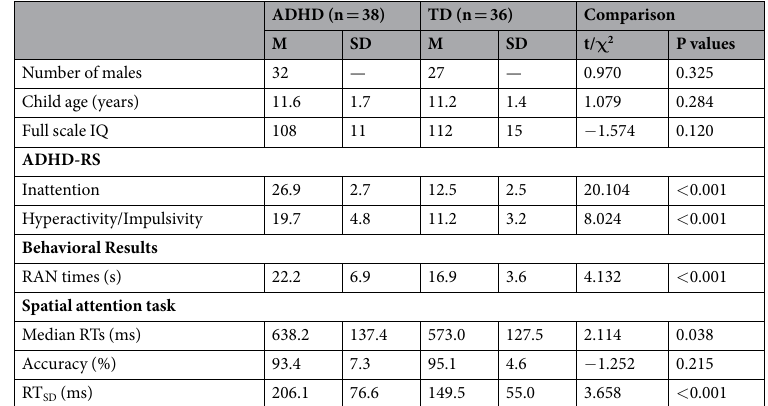
Table 1. Sample characteristics and behavioral results in the ADHD and TD groups. ADHD: attention-deficit/ hyperactivity disorder; TD: typically developing; ADHD-RS: ADHD-rating scales of behavioral symptoms;